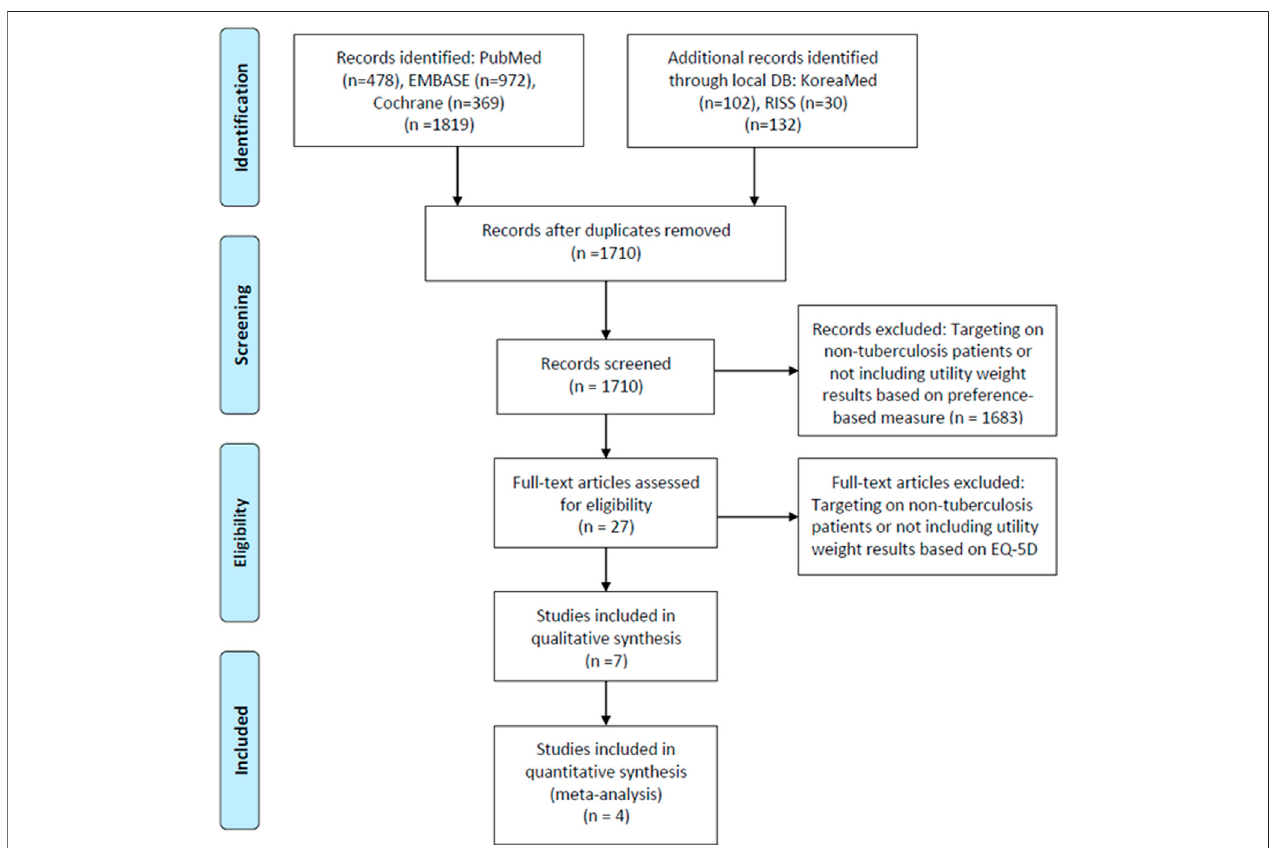
FIGURE 1 | Flow of study